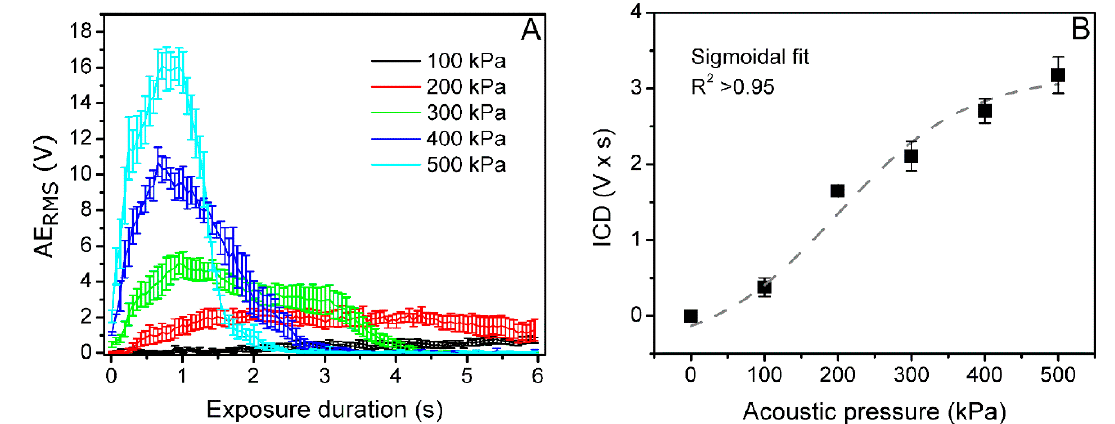
Figure 11. AE RMS curves in exposure duration scale at different acoustic pressure ( A ). ICD in acoustic pressure scale ( B ).